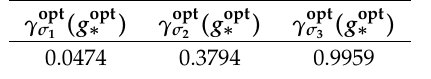
for d = 4 using the graviton anomalous dimension computed via n